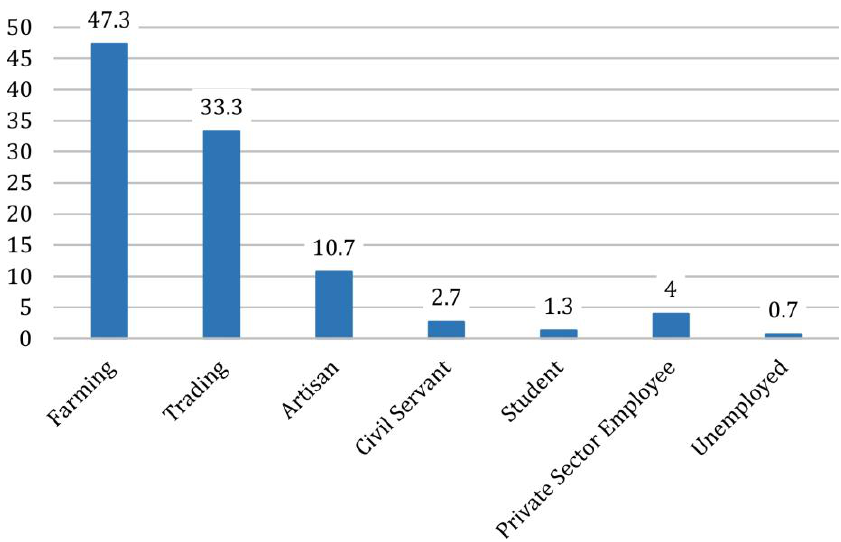
Fig. 2. Respondents occupation (%) (n=150)